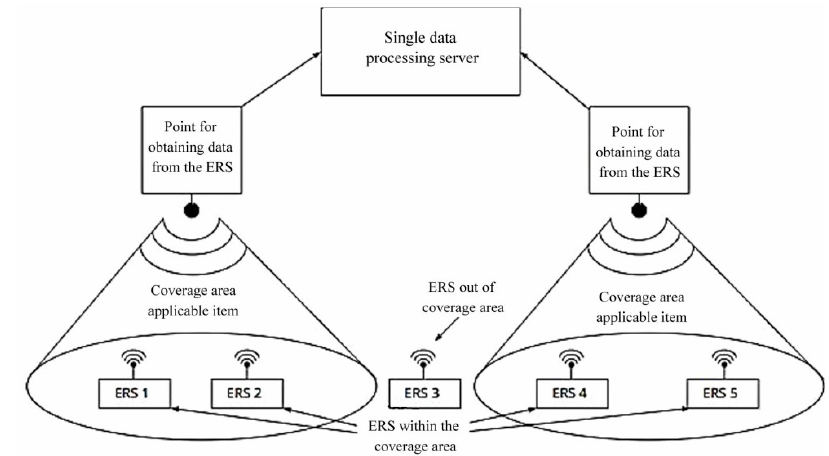
Figure 3. Simplified concept of the power consumption control system.